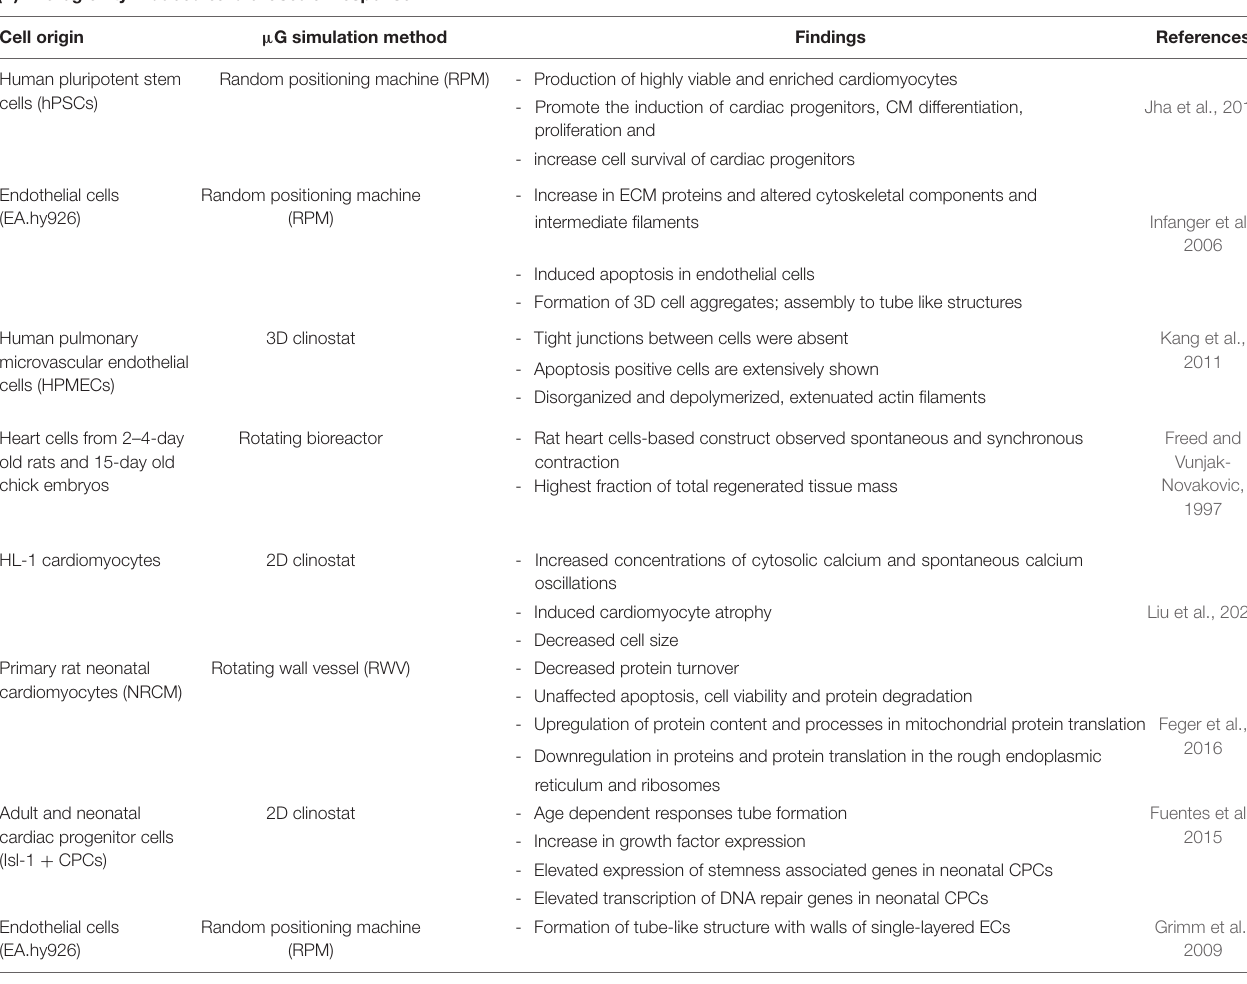
TABLE 1 | Summary of cardiovascular responses to microgravity and